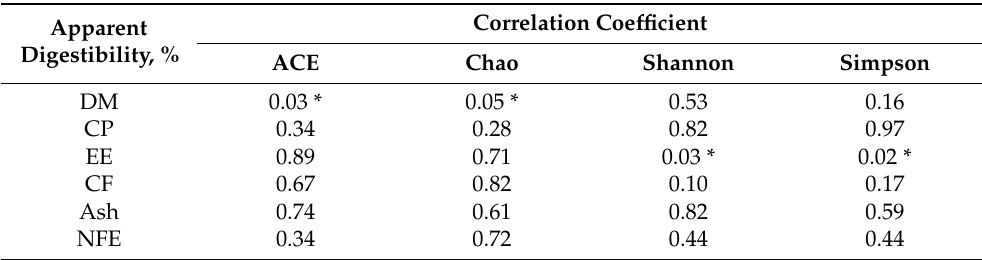
Table 7. Correlations of fecal microbial richness and diversity estimators with apparent nutrient digestibility.